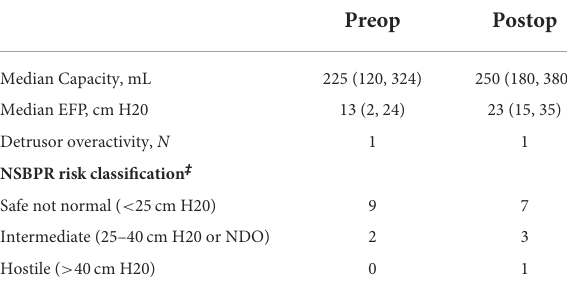
TABLE 4 Urodynamics pre- and postop in patients with no augment *